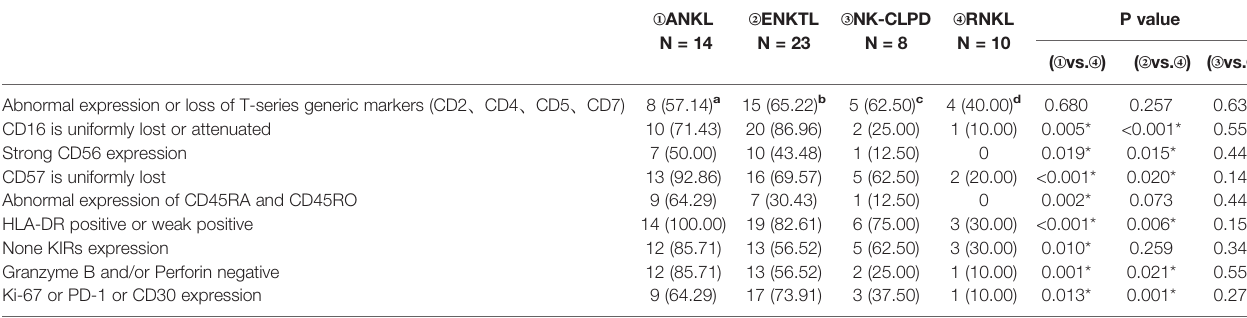
TABLE 3 | Markers to distinguish mature NK cell tumors (ANKL, ENKTL, NK-CLPD) and reactive NK lymphocytosis (RNKL).